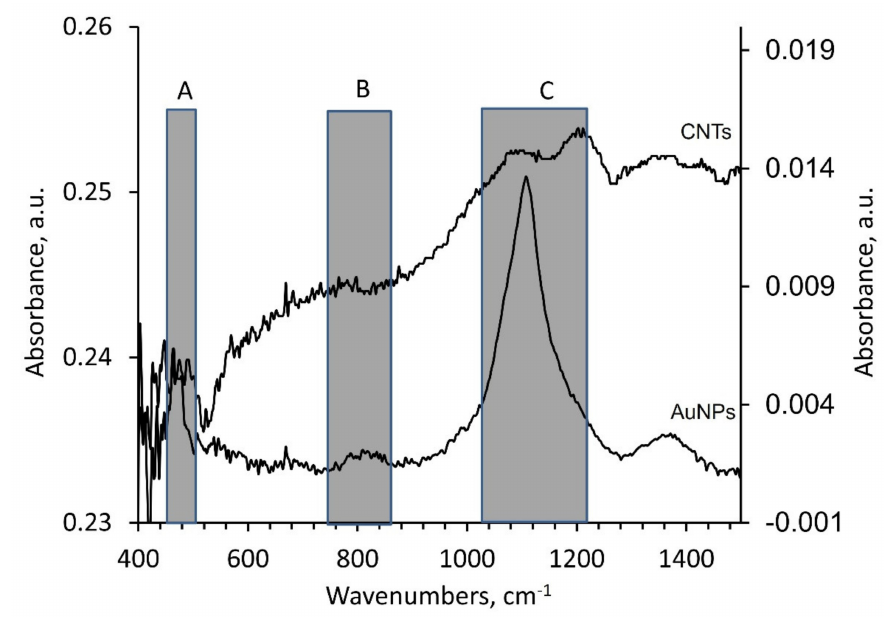
Figure 2. ATR-FTIR spectra of gold nanoparticles (AuNPs, right Y -axis) and carbon nanotube samples (CNTs, left Y -axis). Marked spectral ranges: (A) 450–503 cm − 1 , (B) 750–870 cm − 1 , (C) 1022–1218 cm − 1